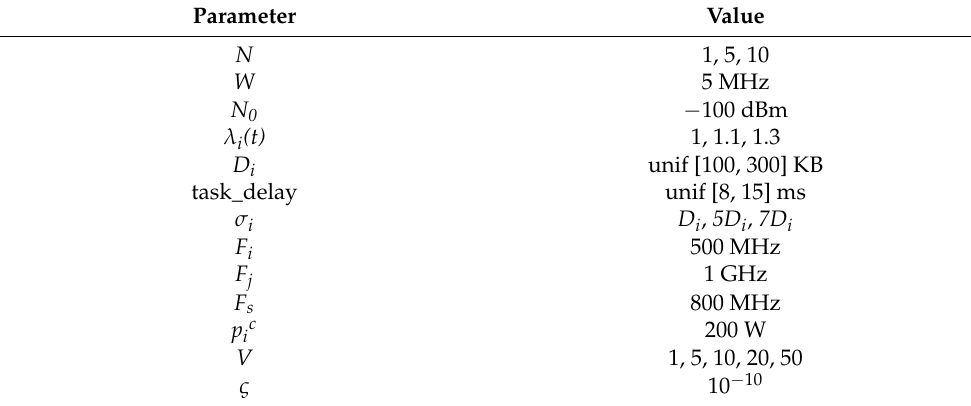
Table 2. Parameter settings in the experiments.